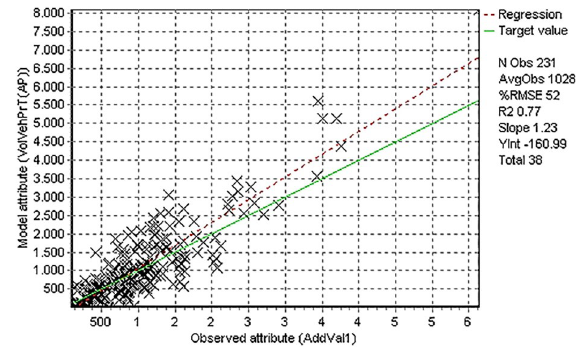
Fig. 6. Model verification